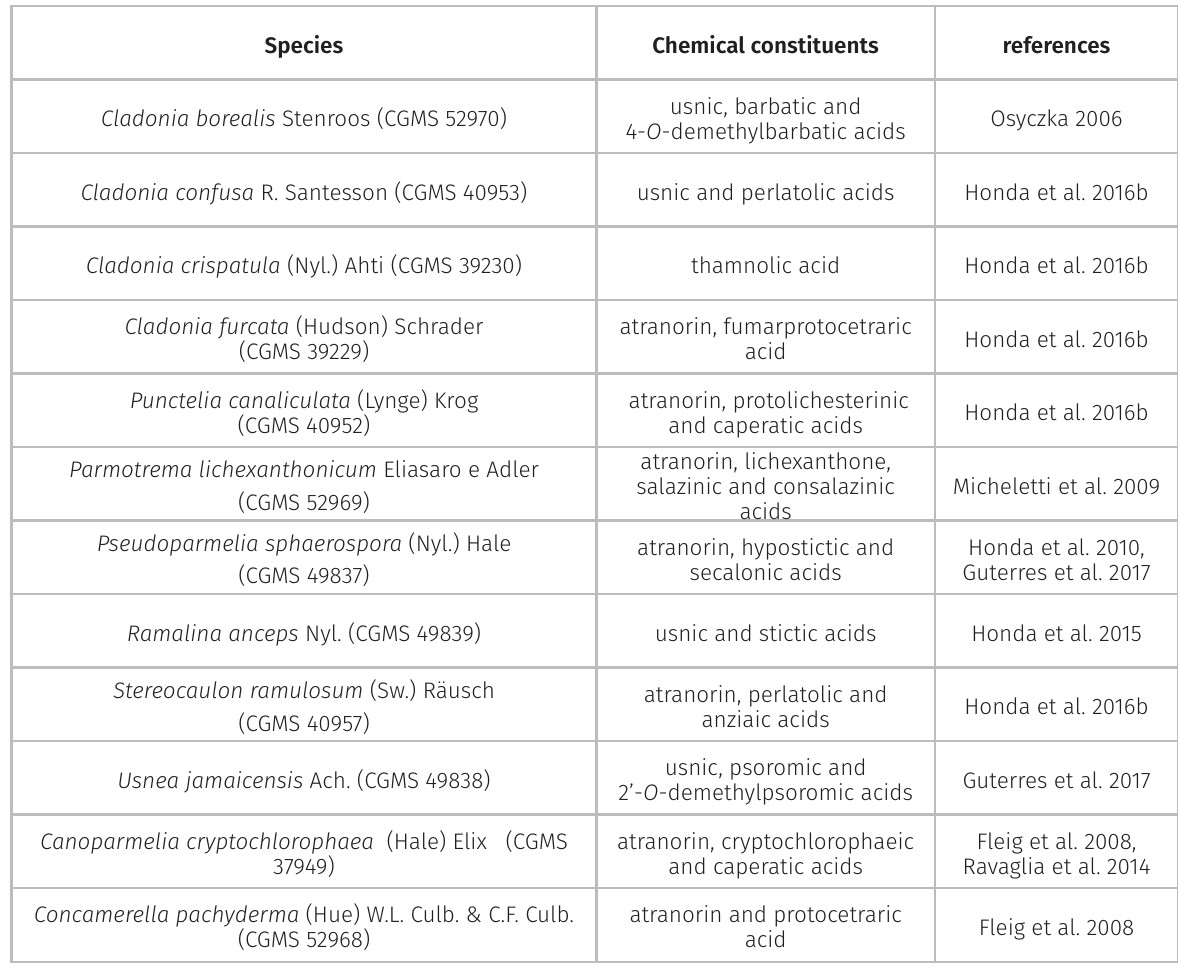
Table I. Studied species and their chemical